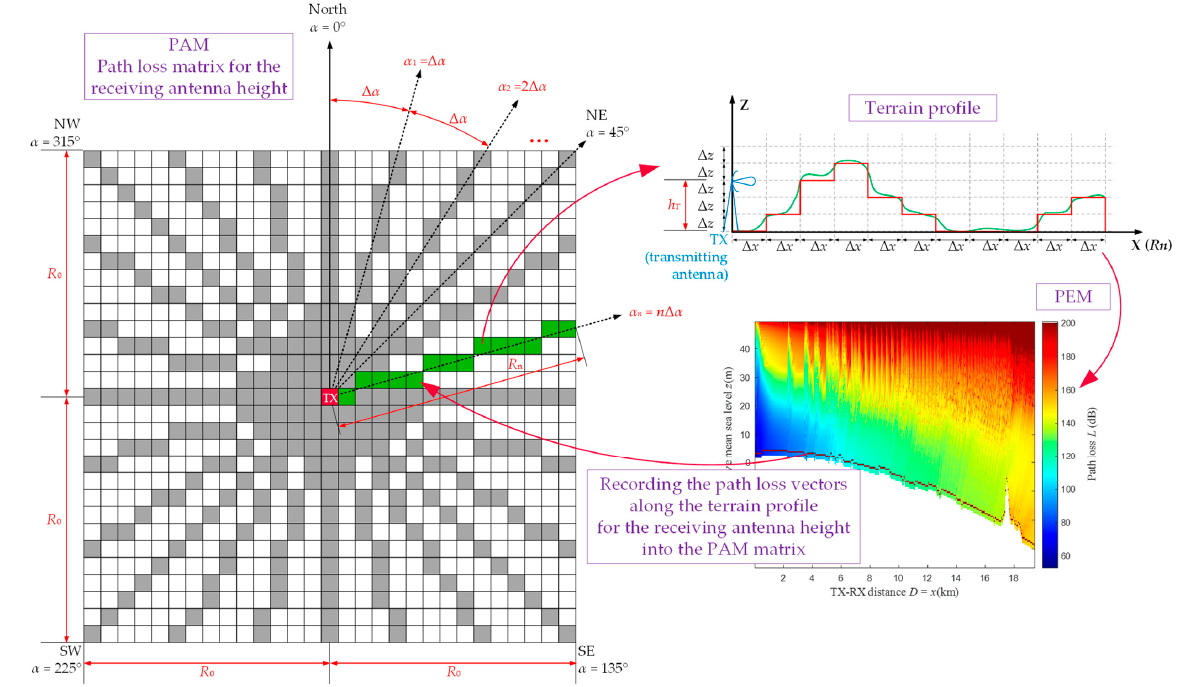
Figure 1. The idea of creating sparse PAM matrix.